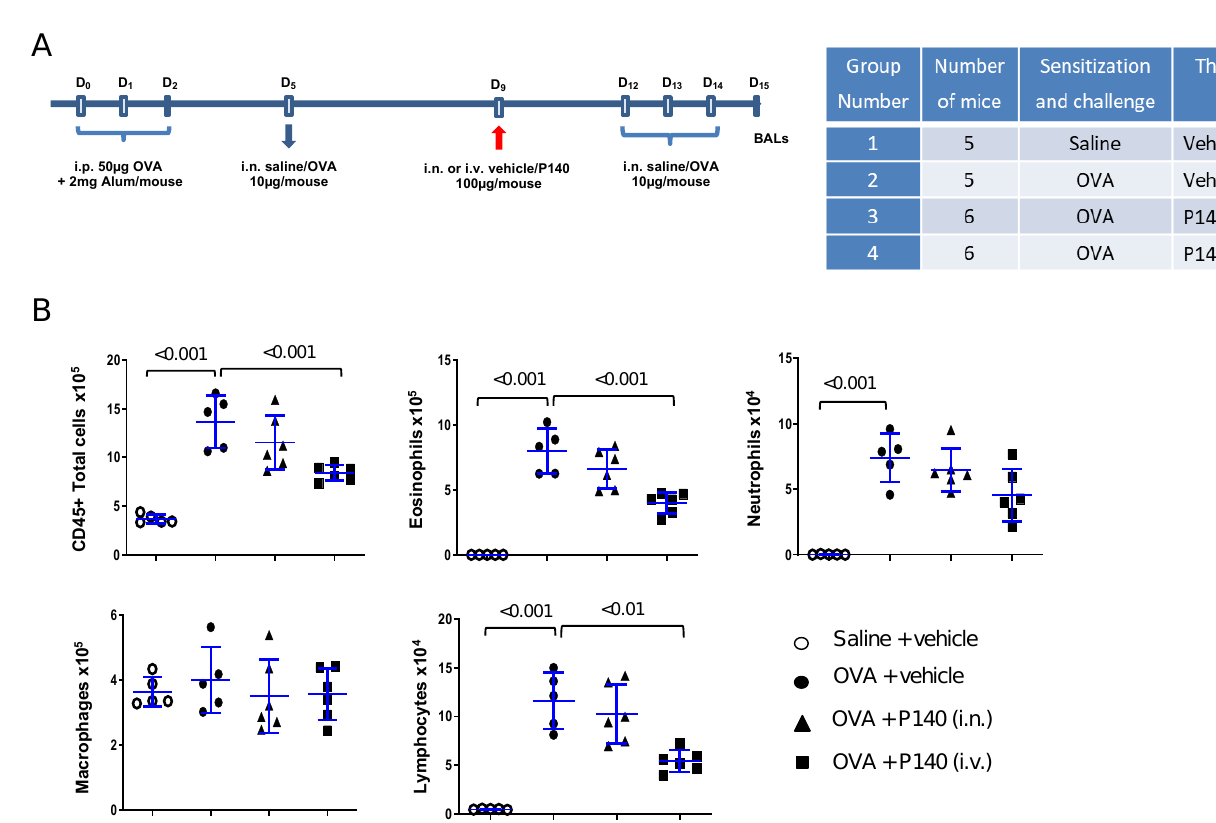
Figure 1. Effect of the P140 peptide on airway inflammatory cell accumulation in an ovalbumin-induced airway hypereo- sinophilia model in BALB/c mice. ( A ) 9-week old male BALB/c mice were sensitized to OVA in saline at days 0, 1 and 2 and then successively challenged with OVA at days 5, 12, 13 and 14. P140 in vehicle (NaCl) was administered i.n. or i.v. at the dose of 4 mg/kg on day 9. BALs were collected at day 15. ( B ) Absolute numbers of total cells, eosinophils, neutrophils, macrophages and lymphocytes in BALs are shown. The data are presented as the mean ± SEM ( n = 5 – 6 mice per group).